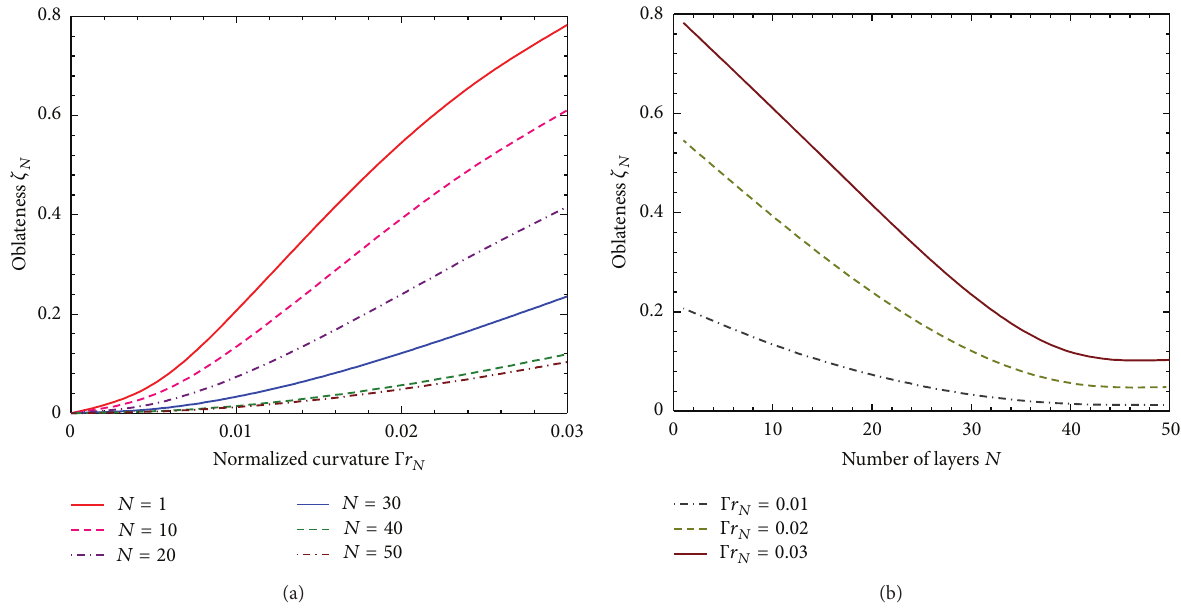
Figure 6: (a) Oblateness 𝜁 𝑁 of the outmost cylinder in an 𝑁 -layered system as a function of the curvature Γ𝑟 𝑁 . The curvature is normalized by the radius of the outmost cylinder 𝑟 𝑁 . (b) Suppression in the oblateness 𝜁 𝑁 with increasing the number of constituent layers 𝑁